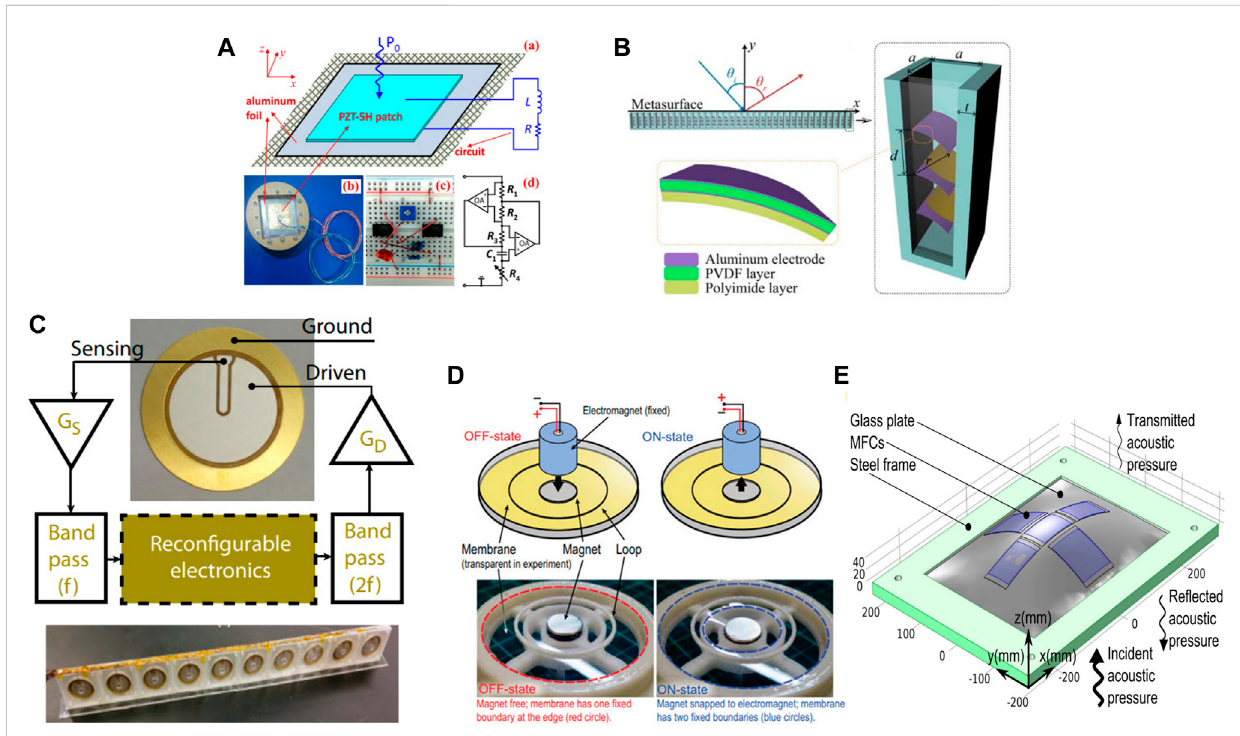
FIGURE 4 Examplesofactivecontrol. (A) SchematicofsmartAM(Zhangetal.,2016). (B) TunableAMbasedontunableunitscomposedofpolyimideunimorph sheets (Li et al., 2022c). (C) Recon fi gurable piezoelectric membrane controlled by electronics (Popa et al., 2015). (D) Membrane can be electrically switched between on and off states (Ma et al., 2018). (E) Sound shielding system consists of a curved glass plate and piezoelectric MFC actuators (Steiger et al.,